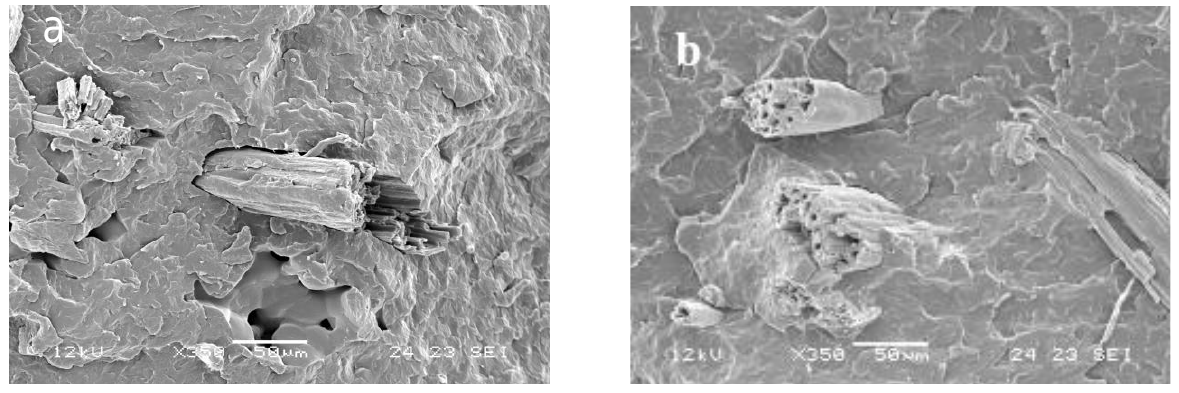
Figure 3. SEM micrographs of (a) PP/Hemp 90/10 and (b) PP/Hemp 90/10 compatibilized with PP- g -GMA (10